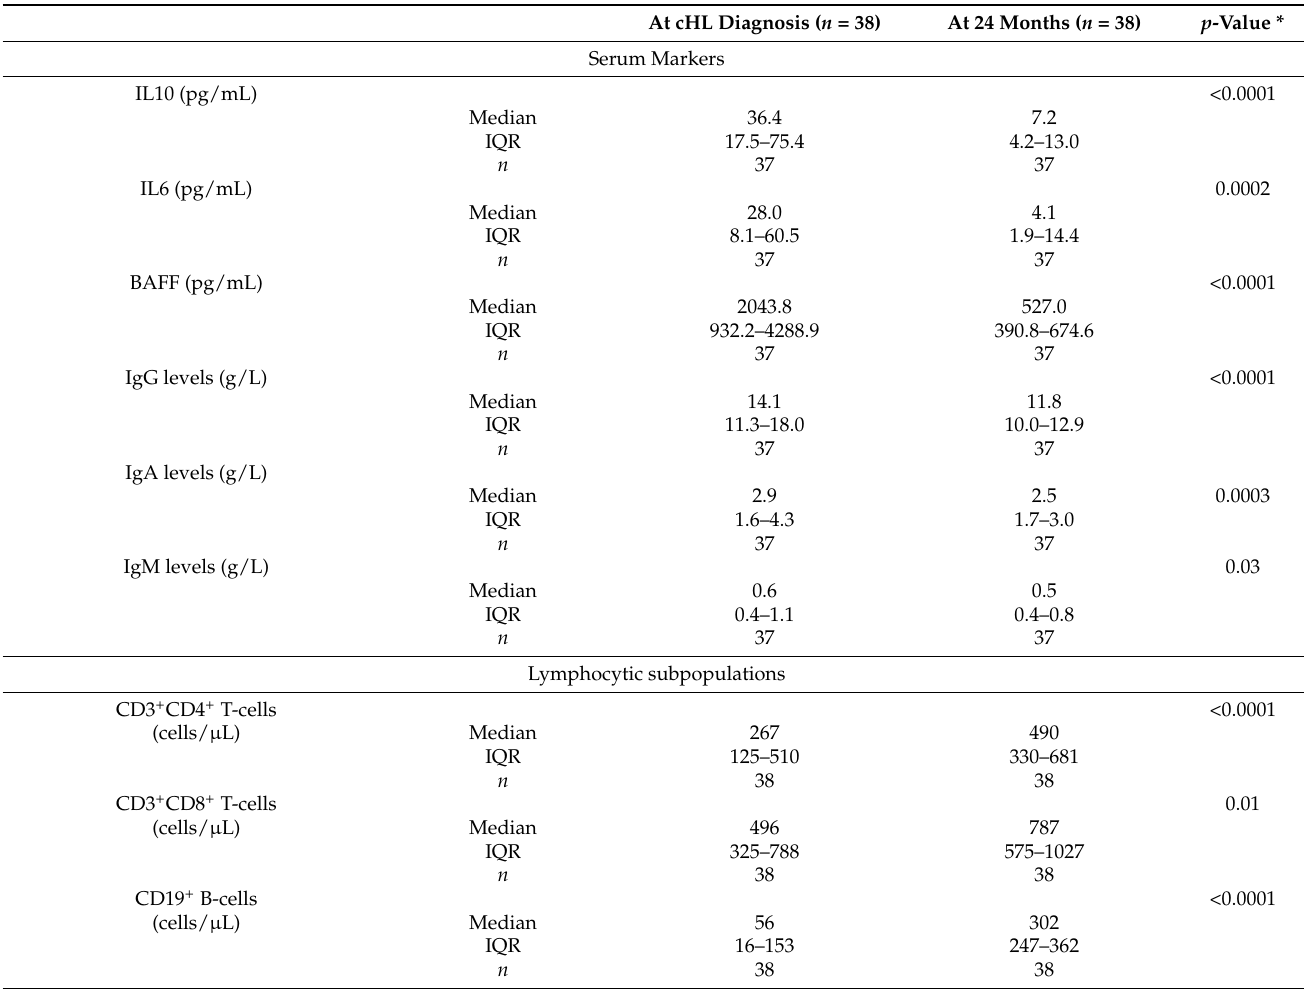
Table 4. Comparison of lymphocyte subsets and serum marker levels collected at HIV- cHL diagnosis and 24 months